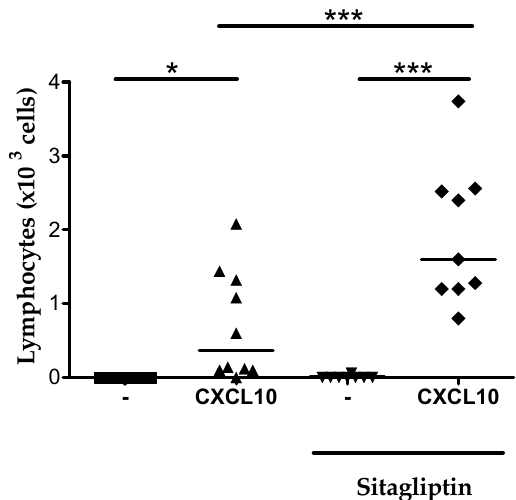
Figure 8. Sitagliptin-treatment of mice enhances CXCL10-mediated lymphocyte extravasation into the joint. The effect of CD26 inhibition on CXCL10-induced lymphocyte extravasation was determined in vivo. Vehicle or CXCL10 were injected into the tibiofemoral articulation of sitagliptin-treated C57BL/6 mice. Total leukocyte numbers migrated into the joint were determined 3 h post injection. Percentages of lymphocytes were differentially counted on May–Grünwald–Giemsa stained cytospins and were used to calculate total lymphocyte numbers. Each symbol represents an individual mouse ( n ≥ 8). Horizontal lines indicate the median number of lymphocytes for each treatment group. Statistical analysis was performed using the Mann-Whitney U test. * p < 0.05, *** p < 0.001.